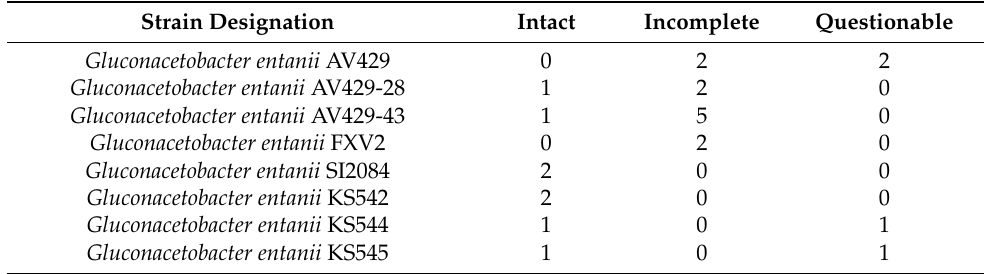
Table 6. Number of prophages identified in Gluconacetobacter entanii